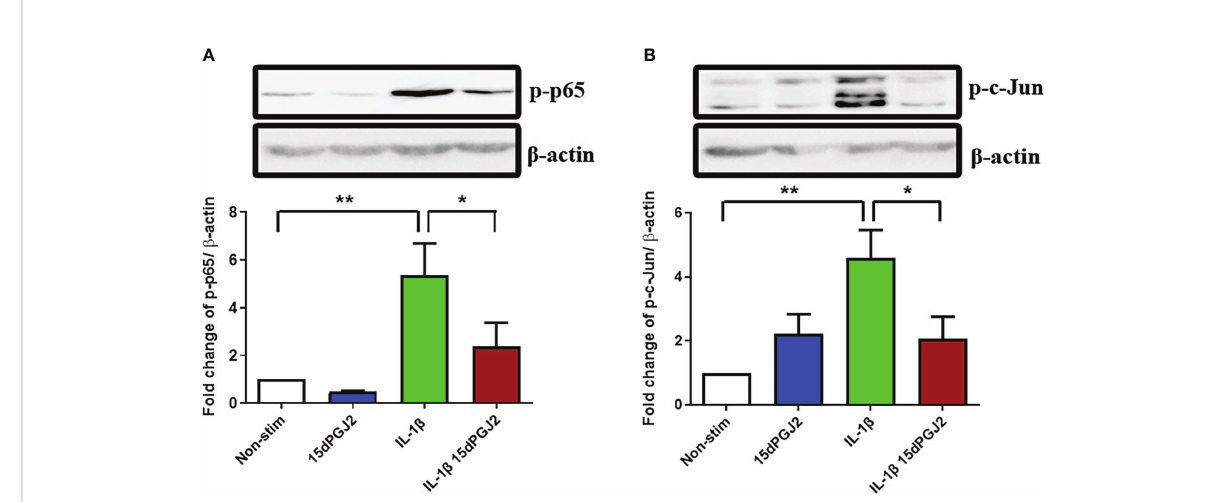
FIGURE 1 15dPGJ2 inhibits IL-1 b -induced NF- k B and AP-1 activation in myometrial cells. Myometrial cells were pre-incubated for 2 hours with 32µM 15dPGJ2 or vehicle control before stimulation with 1ng/ml of IL-1 b for 15 minutes. Whole cell lysates were prepared and assessed by Western immunoblotting for serine 536-phosphorylated p65 (Ser536-p-p65) as a marker of NF- k B activation, and serine 73-phosphorylated c-Jun (Ser73-p-c-Jun) as a marker of AP-1 activation. Representative immunoblots are shown for p-p65 (A) and p-c-Jun (B) with b -actin as a loading control. Densitometry analysis of the immunoblots showed a signi fi cant increase in p-p65 and p-c-Jun with IL-1 b stimulation after 15 minutes ( p <0.01). Pre-incubation with 15dPGJ2 signi fi cantly inhibited IL-1 b -induced p-p65 and p-c-Jun ( p <0.05) activation. n=5-6. * p <0.05, ** p <0.01. Data are presented as mean ±